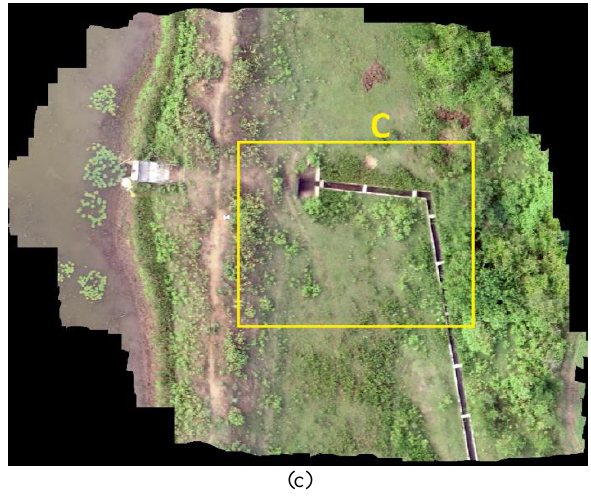
Figure 4: Ortho-mosaic of underneath canopy - (a) plot A, (b) Plot B, and (c) Plot C